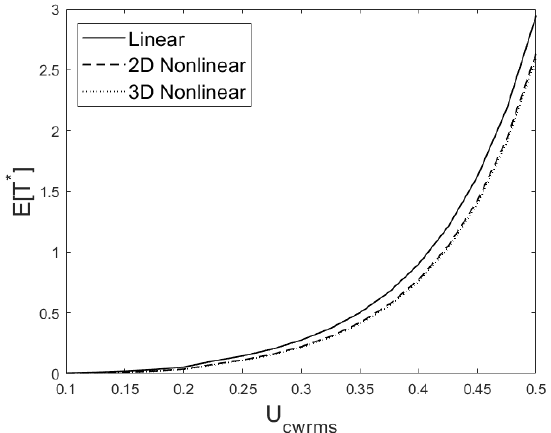
Figure 1. Expected value of nondimensional time scale for scour below pipelines for linear, 2D and 3D nonlinear random waves plus current versus U cwrms .